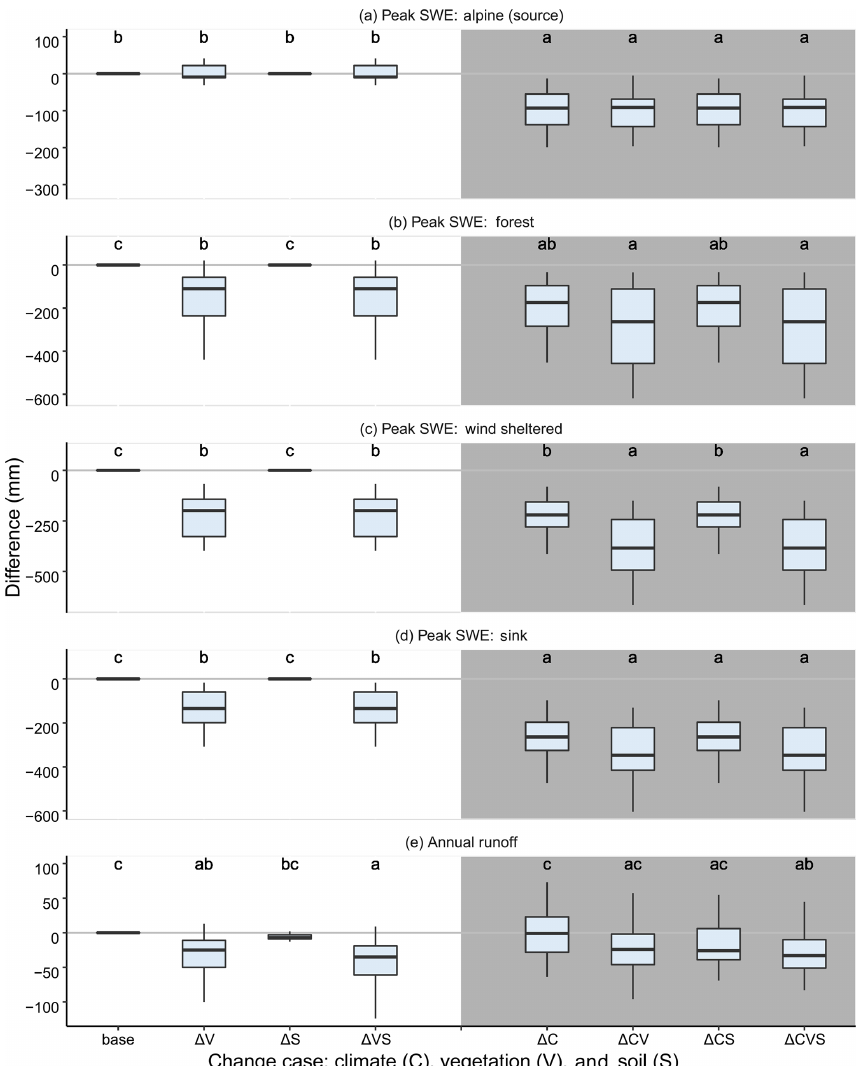
Figure 5. Differences in peak snow water equivalent (SWE) and annual runoff volume under seven combinations of changes in climate, vegetation, and soil in the Reynolds Mountain area relative to present climate, present vegetation, and present soil with no change (base case). Lower case letters from the Tukey HSD test indicate groups that are significantly different from each other. The unshaded cases on the left-hand side of the plot demonstrate changes under modeled present climate, and the shaded cases on the right-hand side of the plot demonstrate vegetation and soil changes under modeled future